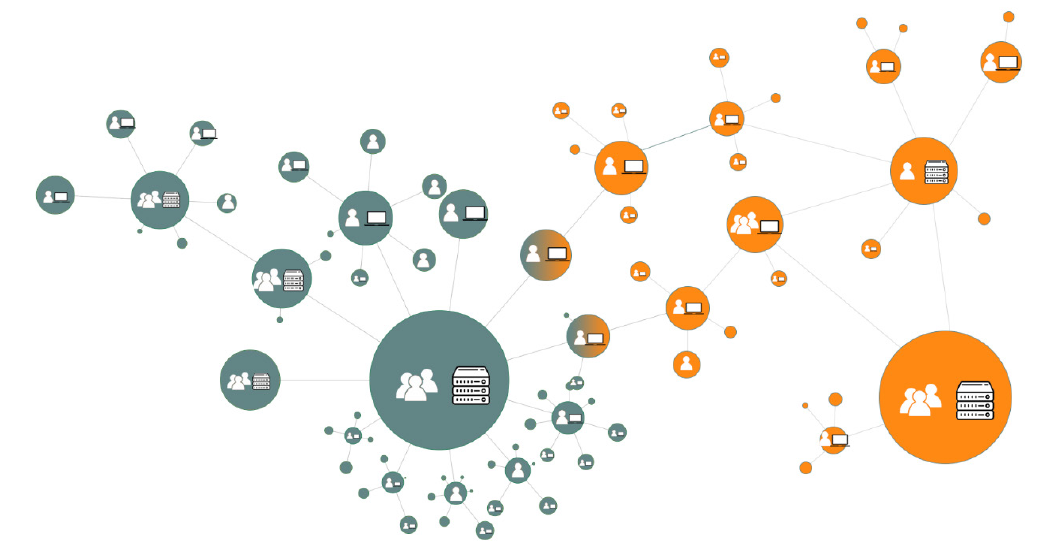
Figure 1. The massive connectivity of computational